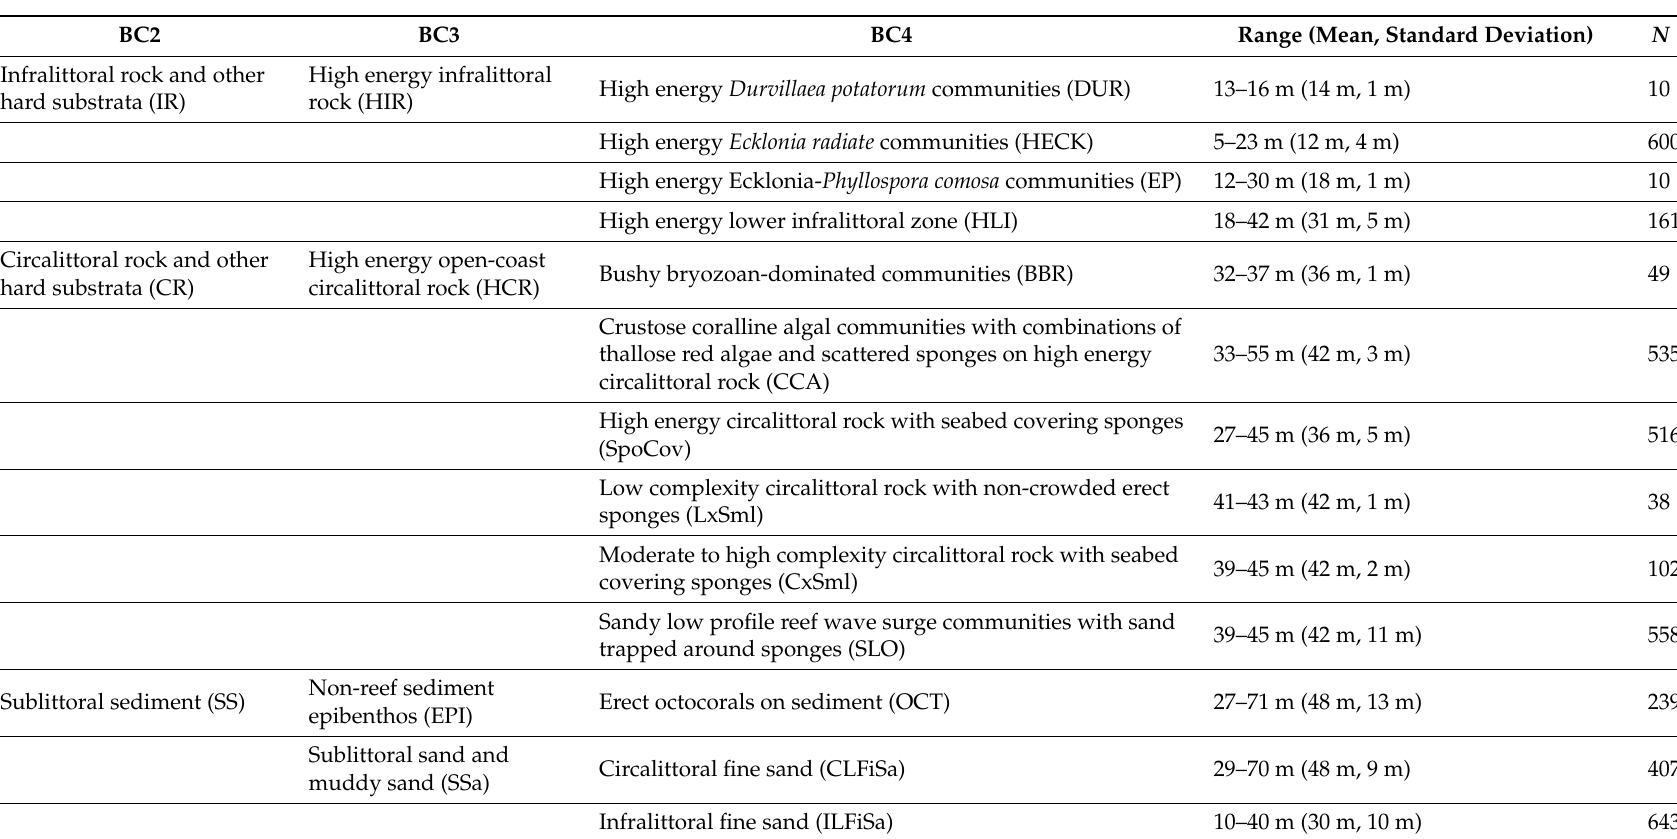
Table 2. Combined Biotope Classification Scheme (CBiCS) hierarchies (BC2, BC3, BC4) used to train and validate the three hierarchical models in the present study with depth range, depth mean, depth standard deviation, and number of observations ( N ) for each level at